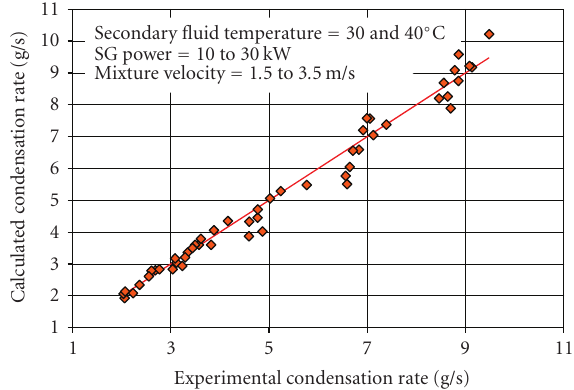
Figure 13: Comparison of a set of experimental data from the CONAN with FLUENT code predictions [35].